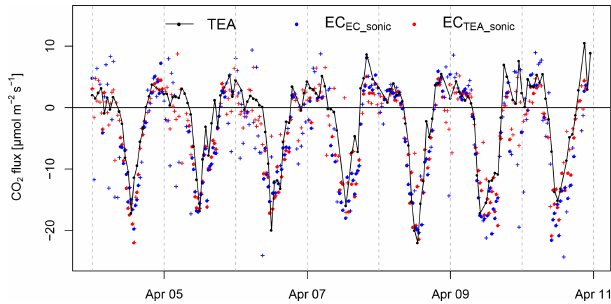
Figure 14. Comparison of CO 2 fluxes measured by true eddy accu- mulation (TEA) and eddy covariance (EC). Flux integration interval for both methods is 30min. TEA fluxes were obtained every 60min and EC fluxes every 30min. The EC fluxes are quality-flag-filtered, accepting flags ≤ 1 on a scale of 0, 1, and 2 (Foken et al., 2004). The two alternative EC flux calculations shown, in blue and red, re- spectively, are from two separate Gill-R3 sonic anemometers using CO 2 density data from the same LI-7500 gas analyzer. The symbols indicate if EC flux estimates from the two sonic anemometers were within 50% from each other (full circles) or not (crosses).